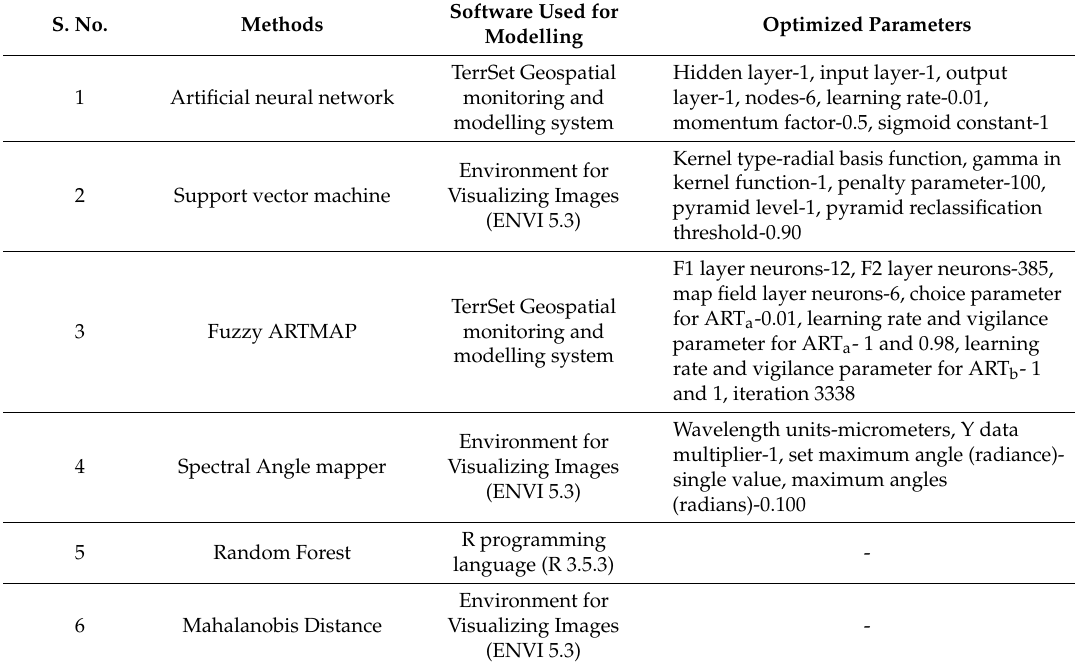
Table 2. Optimized parameters for di ff erent classifiers used for the LULC modelling. S.